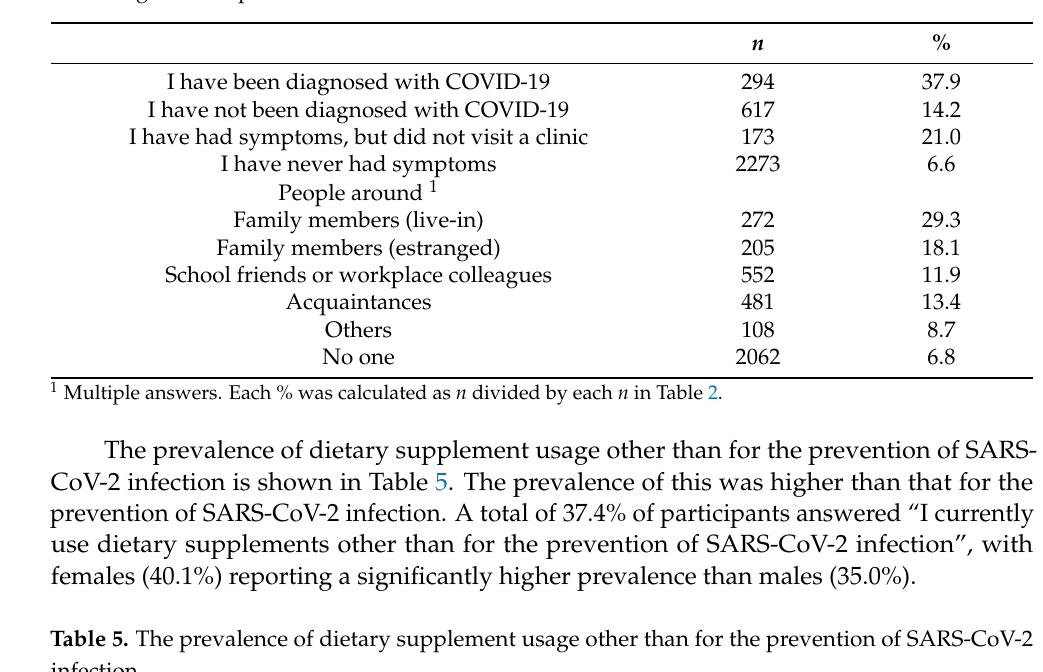
Table 4. The prevalence of dietary supplement usage for the prevention of SARS-CoV-2 infection according to the experience of SARS-CoV-2 infection.